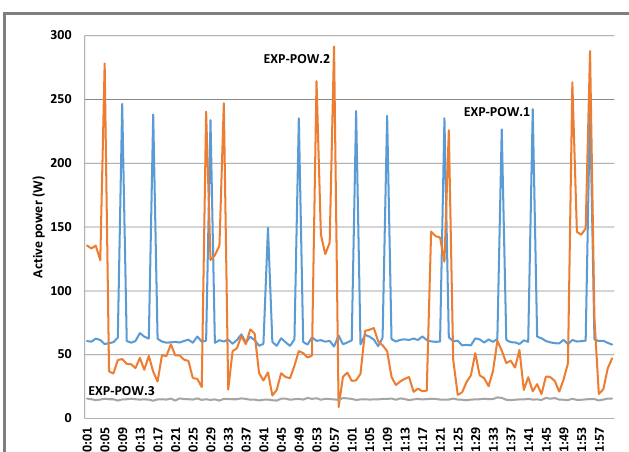
Fig. 15. Active power of the separate